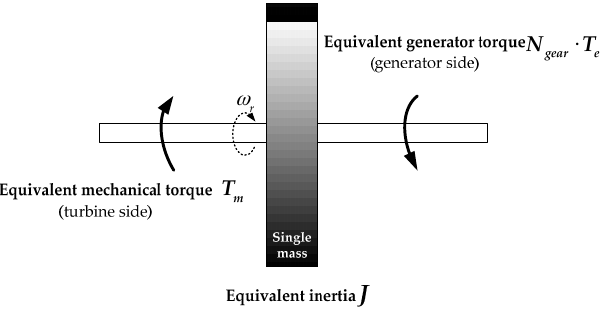
Figure 2. One-mass drive train model.